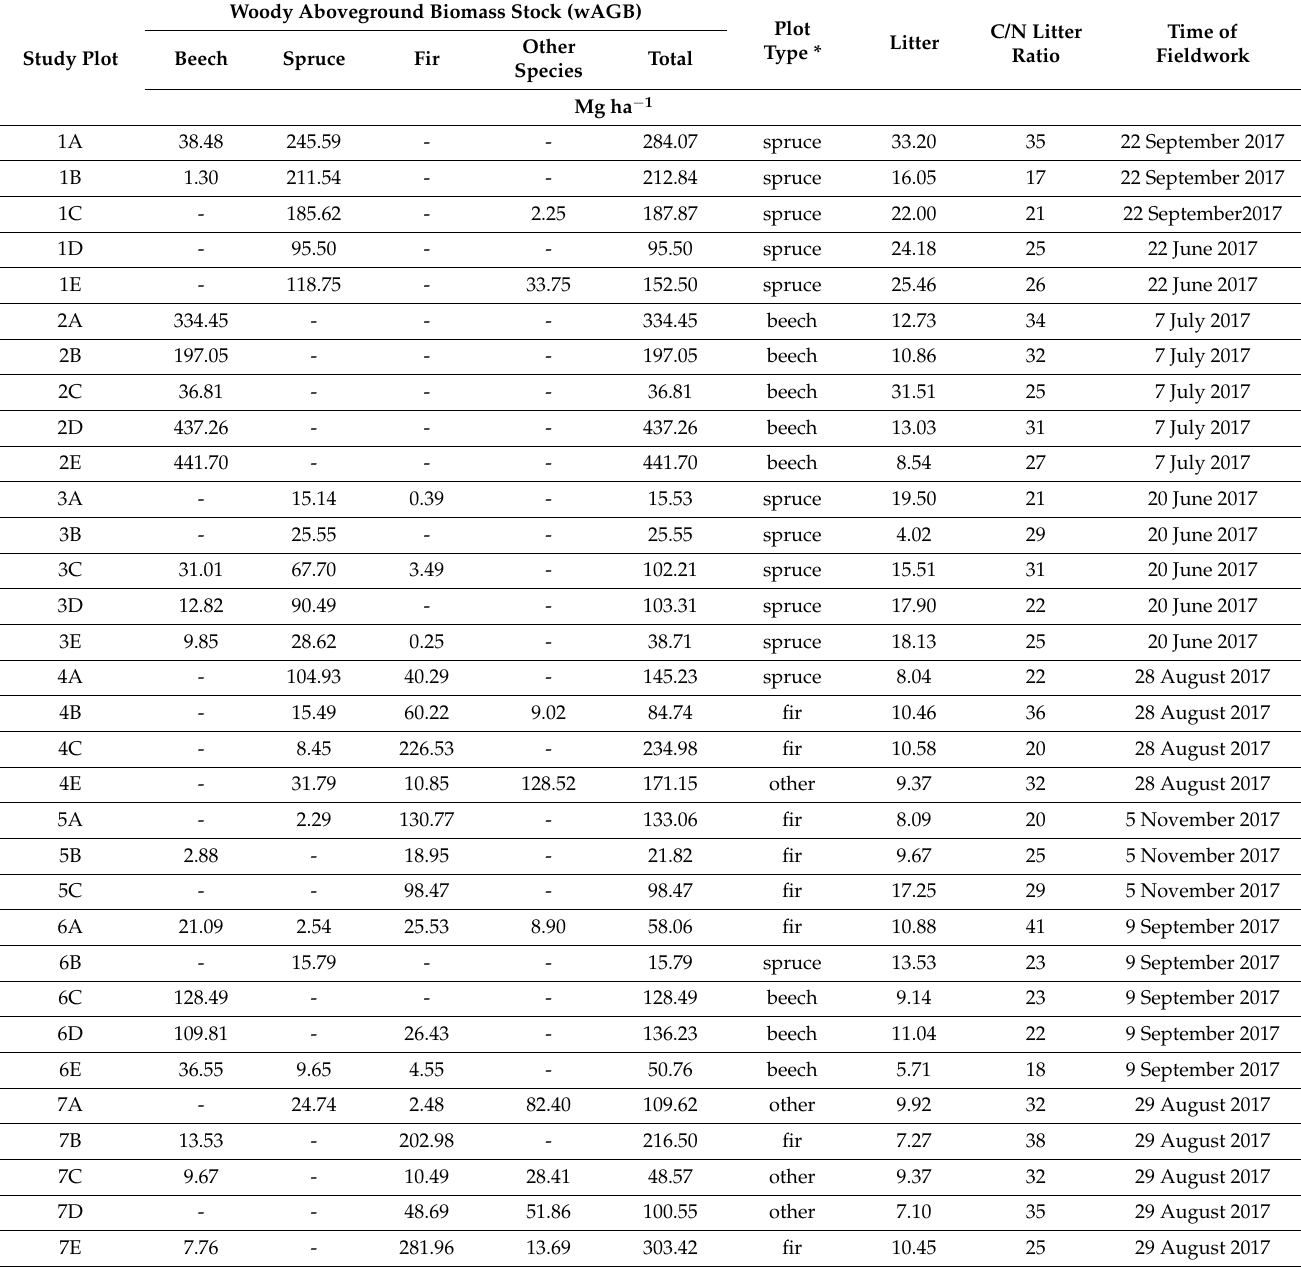
Table 3. Woody aboveground biomass stock and litter biomass